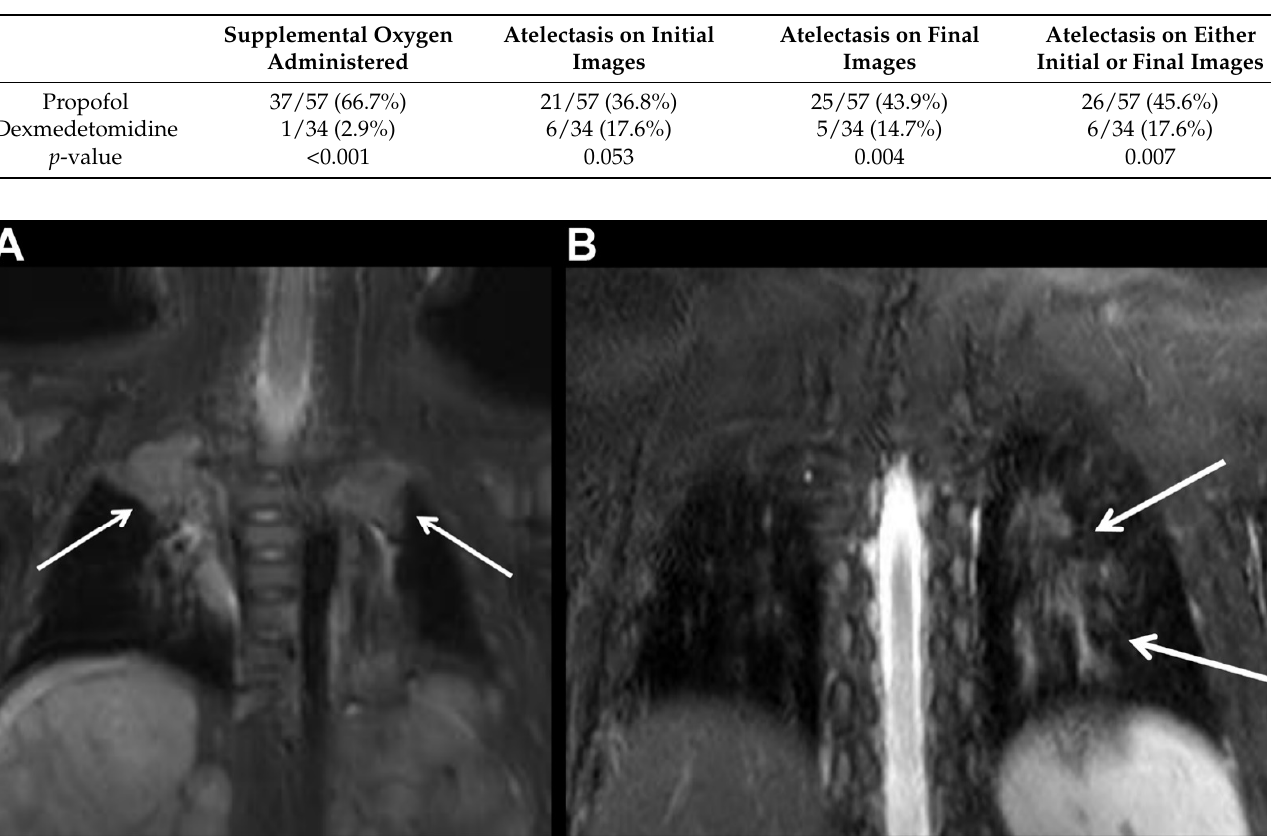
Table 4. Rate of atelectasis occurrence according to the atelectasis grade on final images. Group n